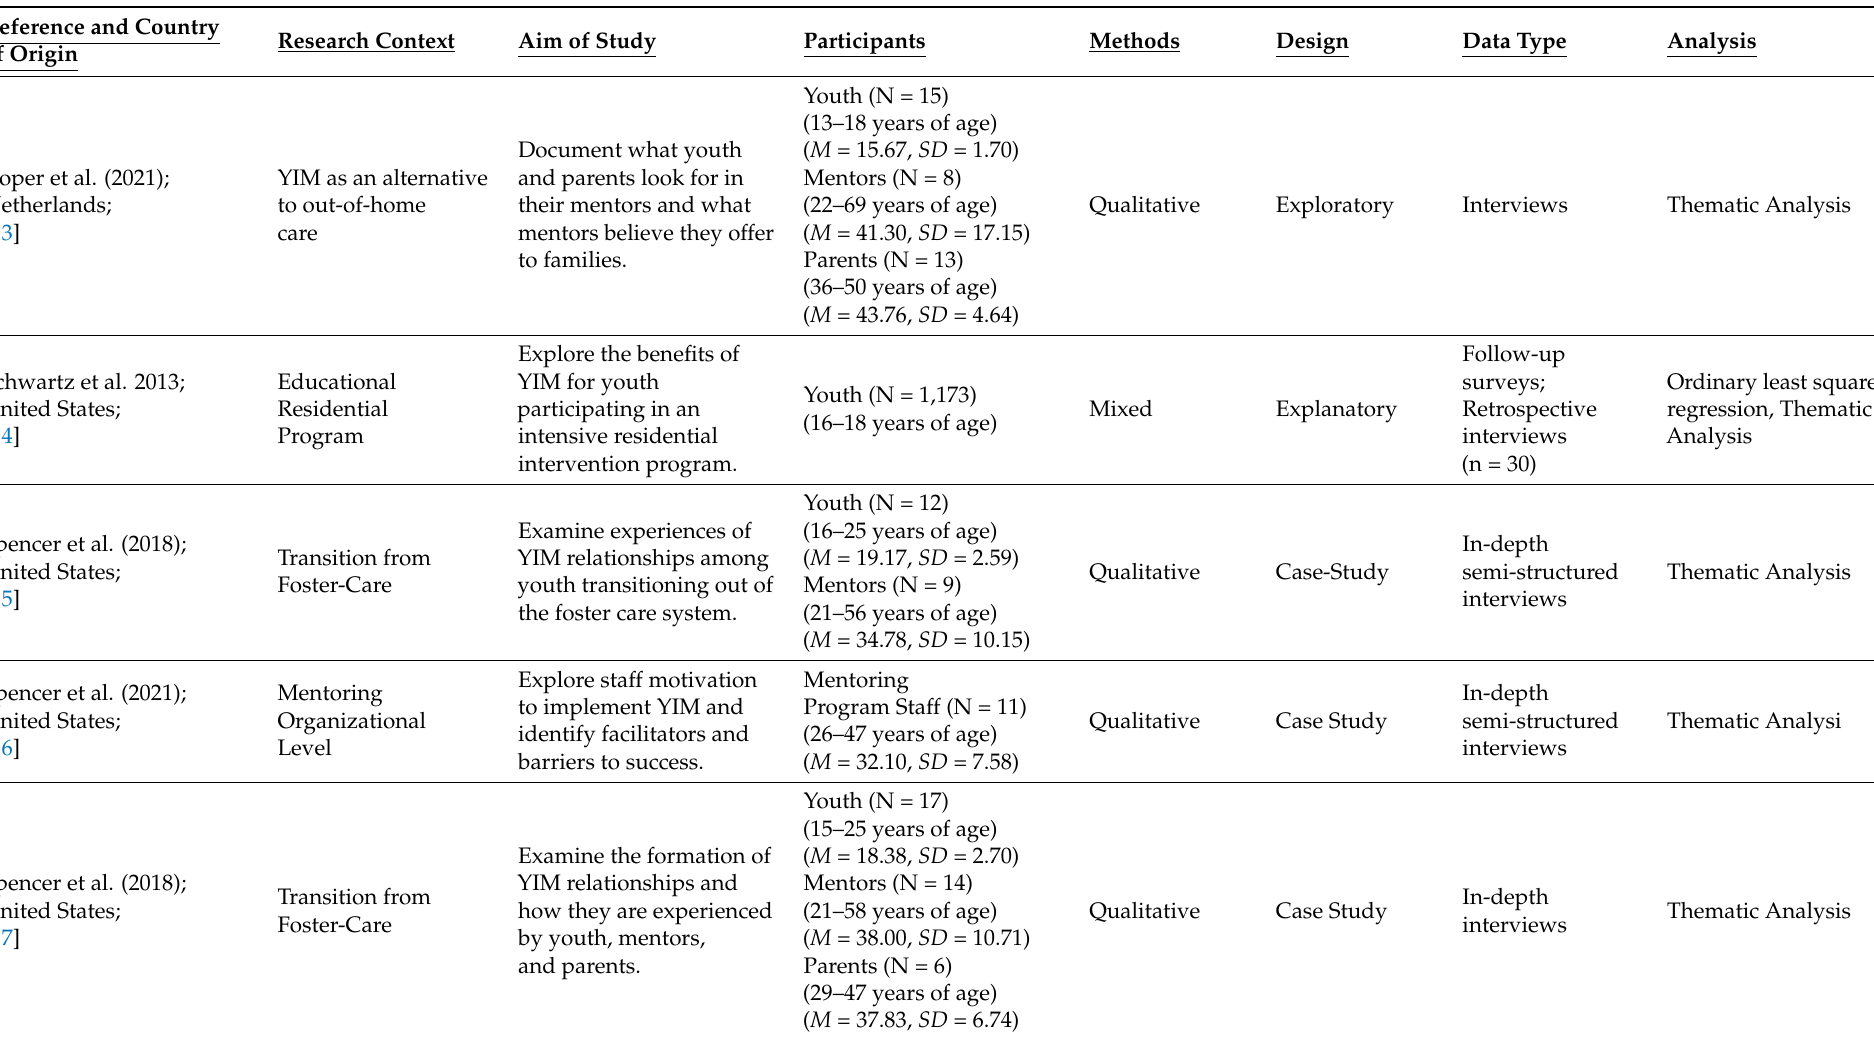
Table 1. Characteristic of Previous Studies on